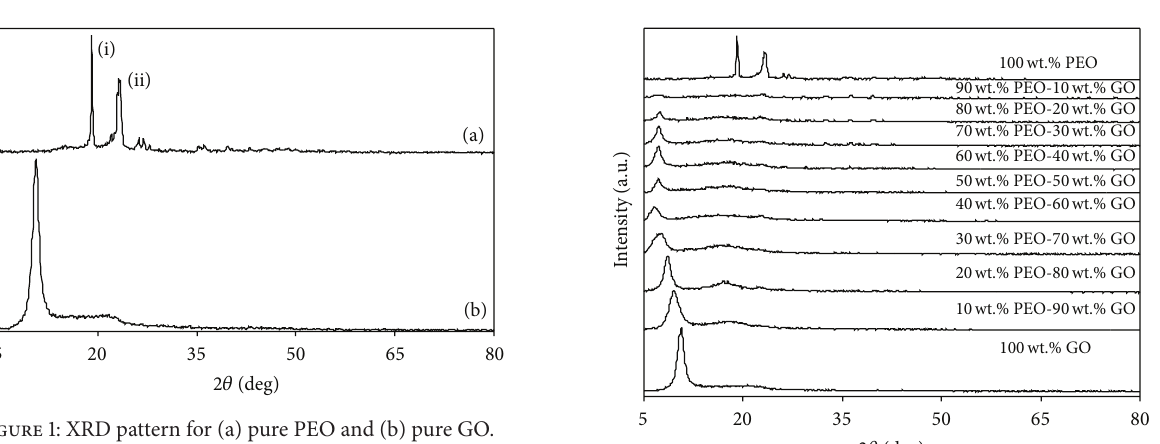
the lower angle 2 𝜃 = 9.8 ∘ with the presence of 10 wt.% of PEO in the blend and the trend is similar for 20 wt.% of PEO (2 𝜃 = 8.7 ∘ ), 30 wt.% PEO (2 𝜃 = 7.8 ∘ ), and 40 wt.% of PEO (2 𝜃 = 6.8 ∘ ). At 50 wt.% PEO-50 wt.% GO blend, GO peak